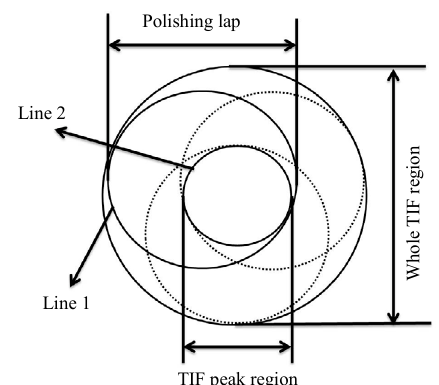
Fig. 7 Schematic picture of orbital motion (note: the line 1 and line 2 represent the high pressure at the lap edge and the edge of the TIF peak region, respectively; the dashed line indicates the lap position distribution region).